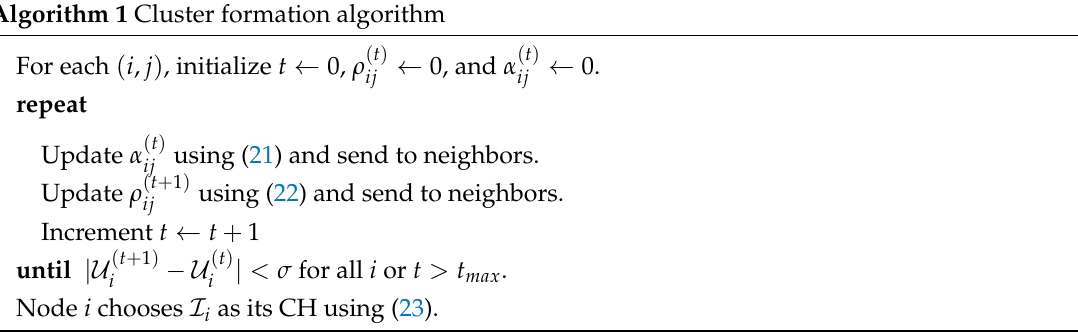
Algorithm 1 Cluster formation